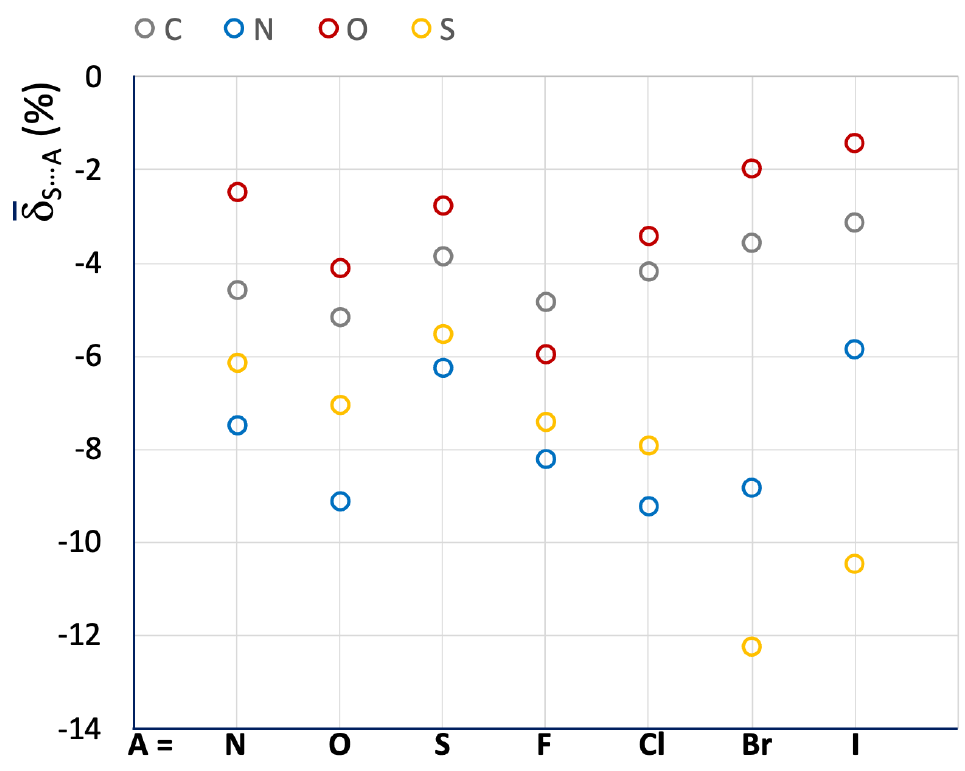
Figure 4. Mean δ S ··· A values calculated for R–S · · · A fragments. A = N, O, S, F, Cl, Br, and I; R = C Figure 4. Mean δ̅ S···A values calculated for R – S···A fragments. A = N, O, S, F, Cl, Br, and I; R = C (grey), N (blue), O (red), and S (grey), N (blue), O (red), and S (yellow).